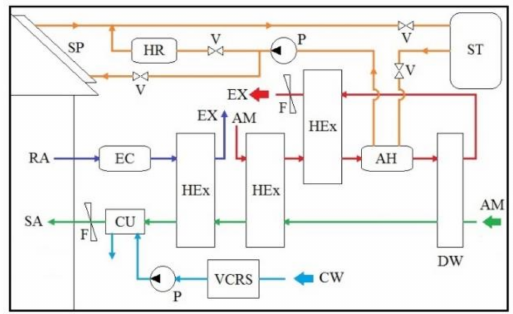
Figure 10. Schematic diagram of Hybrid SDEC and VCRS.